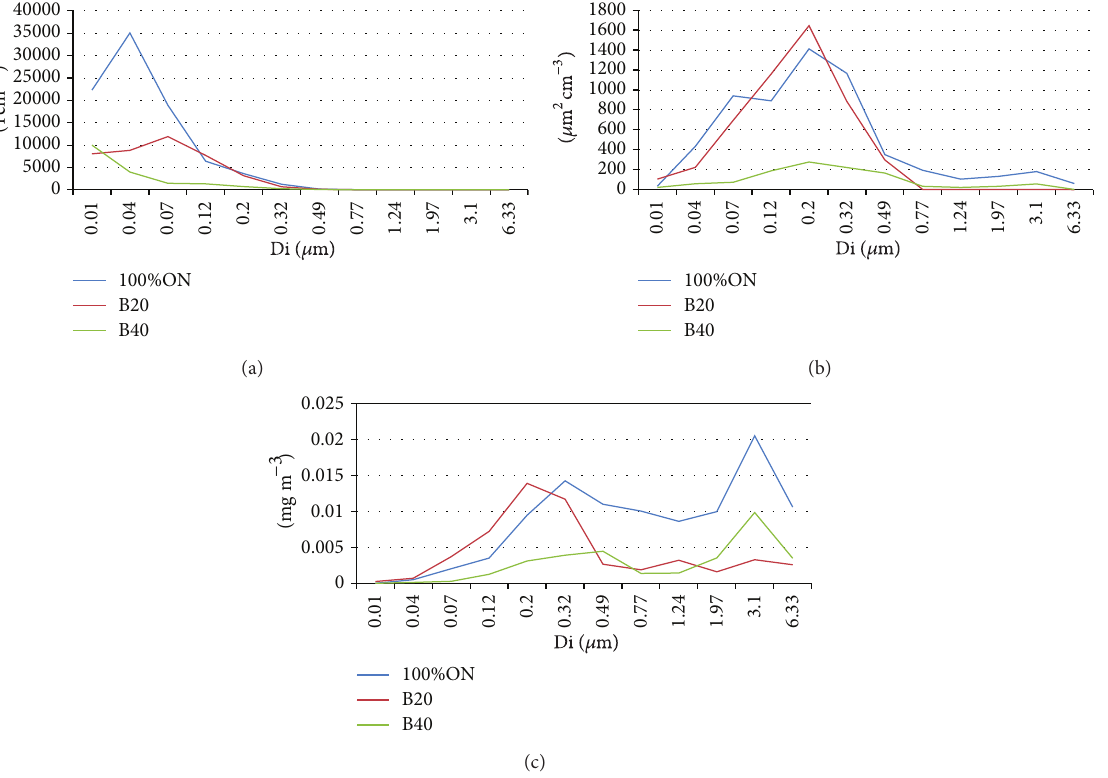
F 3: Mean values of number (a), size (b) and mass concentrations distribution (c) for three biofuel mixtures. Legend: Di geometric mean of a channel (aerodynamic diameter), [